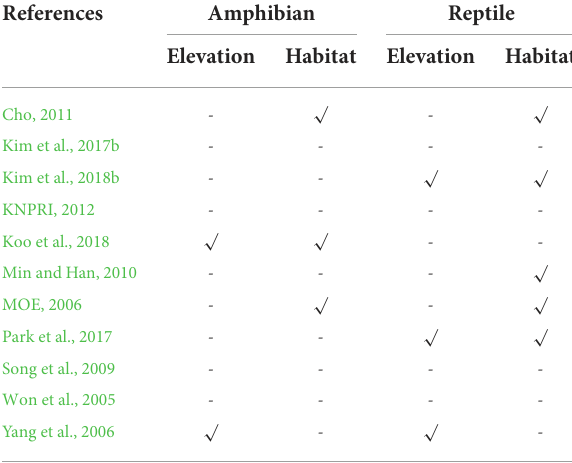
TABLE 1 The list of published literature used to generate literature-based